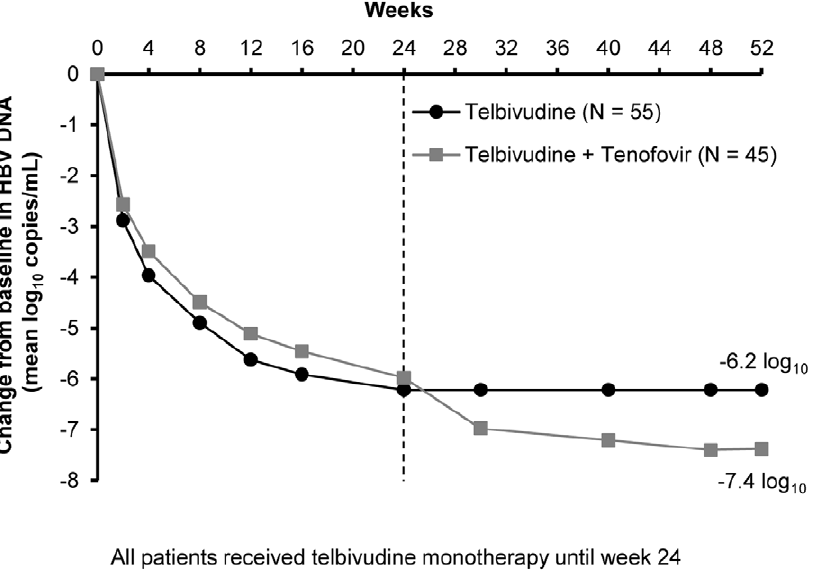
Figure 3. Changes from baseline in HBV DNA by post-Week 24 treatment (efficacy population). doi:10.1371/journal.pone.0054279.g003 PLOS ONE |